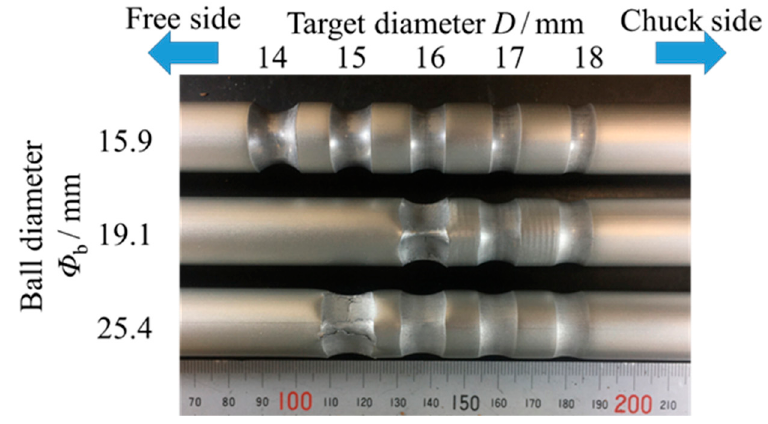
Figure 13. Appearance of formed tube when f R = 0.042 mm/rev. Table 3. Cross-section of formed tube when f R = 0.042 mm/rev.